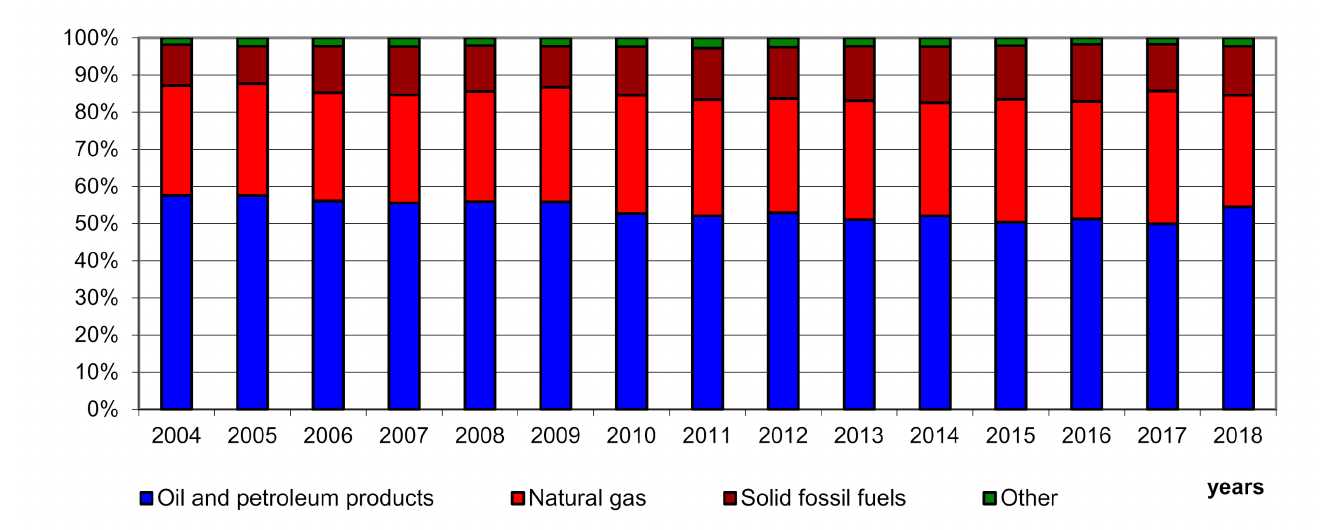
Figure 4. Share of energy import sources in Germany in 2004–2018. In the Netherlands, between 2004 and 2018, energy demand decreased by 9% and its production by 46%. Interestingly, both exports (by 38%) and imports of energy resources (by 45%) increased during this period. The Netherlands is one of the countries that trade in energy resources. Some of the purchased raw materials were subject to foreign trade, making it possible to earn money on this type of activity. In 2018, crude oil dominated in energy imports (73%). Natural gas (21%) and solid fuels (4%) were of less importance (Figure 5). In the years 2004–2018, natural gas imports increased the fastest in relative terms (by 223%). Growth was also recorded in renewable energy (81%), electricity (25%), and oil (28%). Substantial fuel imports fell by 6%.